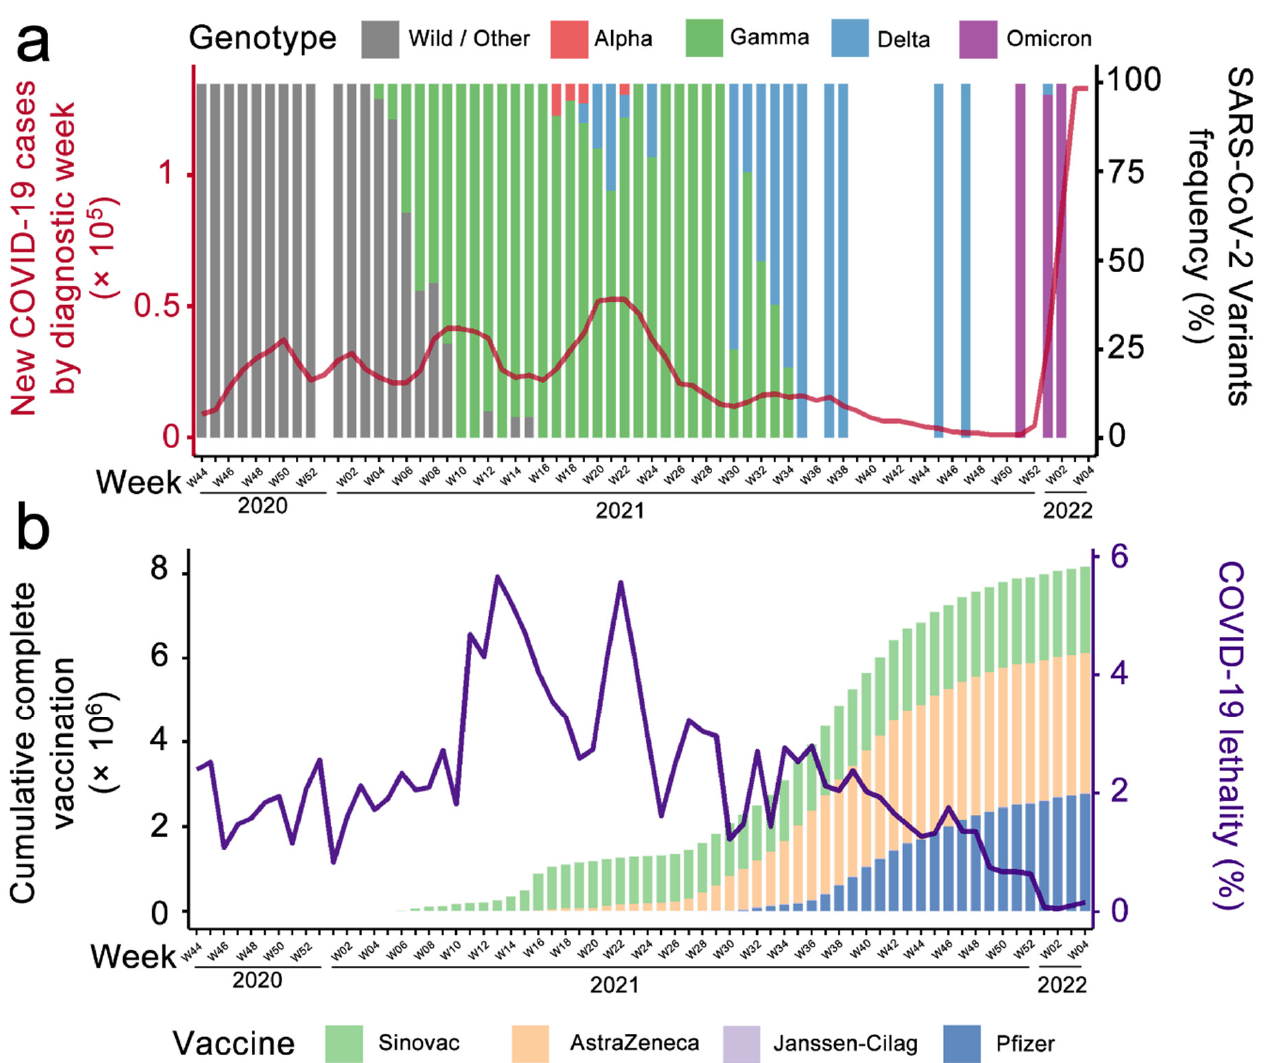
Figure 1. SARS-CoV-2 variants, number of cases, lethality, and vaccination in Paran á State, Southern Brazil. ( a ) New COVID-19 cases (red line, left axis) are grouped by epidemiological week. Colored bars (right axis) indicate the frequency of Wild, Alpha, Gamma, Delta, and Omicron variants in Curitiba, Paran á . ( b ) The cumulative complete vaccination (left axis) in Paran á State, Brazil, in millions of habitants, is stratified by vaccine manufacturer: Sinovac (inactivated virus, two doses), AstraZeneca (Adenovirus, two doses), Janssen-Cilag (Adenovirus, two doses, despite manufacturer single-dose regimen suggestion), and Pfizer (mRNA, two doses). COVID-19 lethality (right axis) is defined as deaths or registered cases in each epidemiological